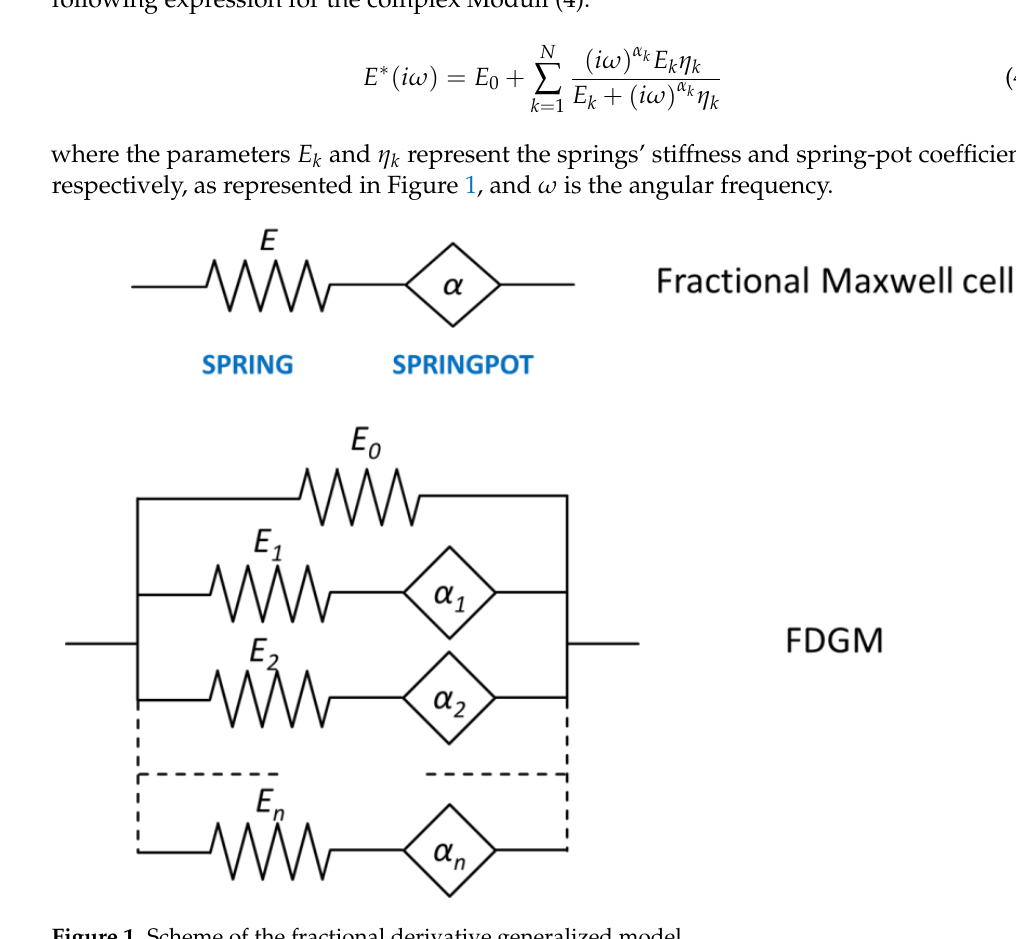
Figure 1. Scheme of the fractional derivative generalized model.